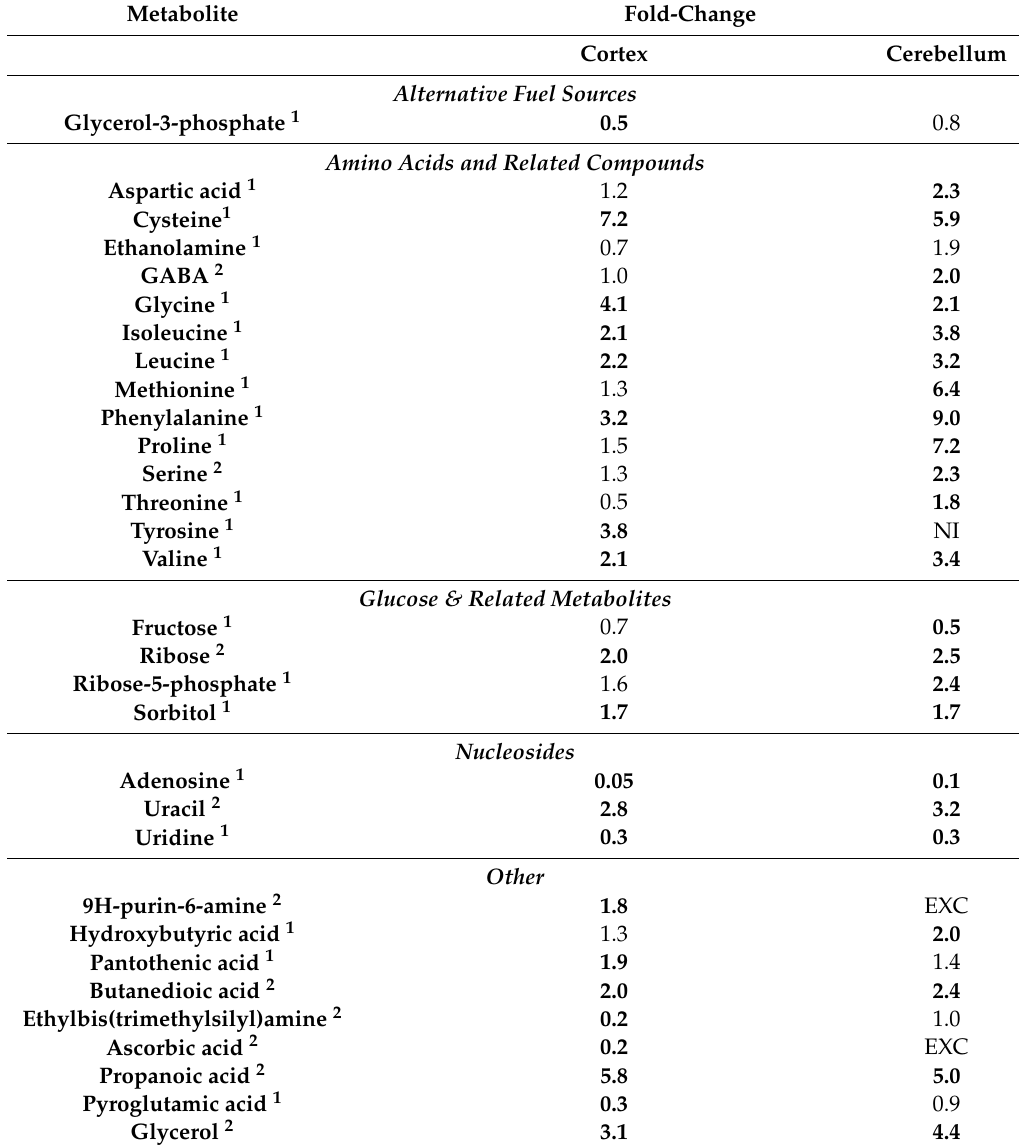
Table 3. Metabolites Significantly Altered in Rat Brain